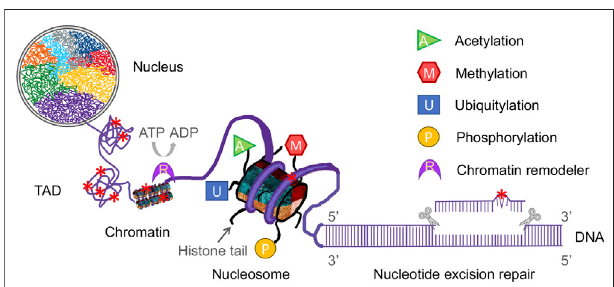
FIGURE1| Diagrammaticrepresentationofthecomplexcomponentsof epigenetics and nucleotide excision repair in a eukaryotic nucleus. Eukaryotic genomic DNA is wrapped around a histone octamer to form a nucleosome, whichistherepeatingunitofthechromatin.Chromatin fi berisfoldedinto a hierarchy of loops and coils to form topologically associating domains (TADs). In this way, eukaryotic DNA is compacted into chromosomes in a nucleus. Each chromosome has its own territory (shown as different colors) in the nucleus. Nucleotide excision repair (NER) removes a wide range of DNA damage (denoted as red star) in cellular DNA and NER machinery requires access to damaged DNA in chromatin. Modi fi cations of histone tails, such as acetylation,methylation,ubiquitylationandphosphorylation(shownasvarious colored shapes), and chromatin remodeling catalyzed by remodelers (shown as a purple crescent) affect the genome architecture and thus regulate the NER